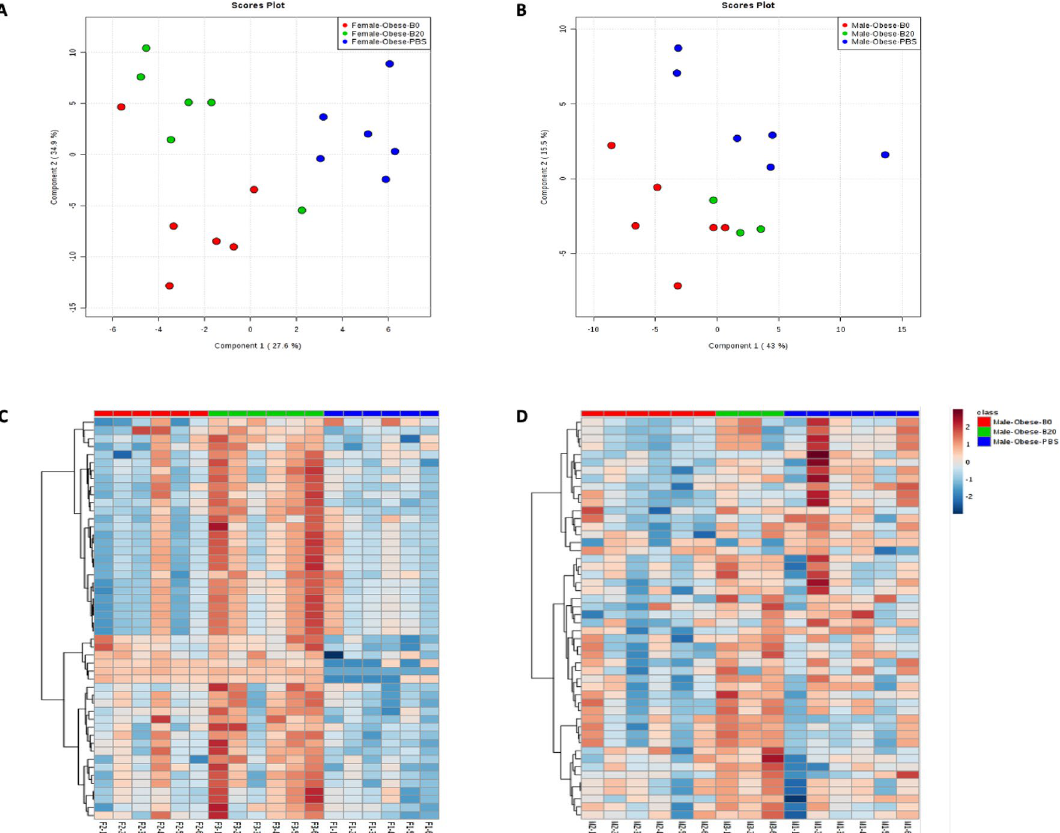
Figure 3. Gut microbial metabolic profiling of female and male mice based on the metabolomic analysis of cecum samples. Within each sex, the B0, B20, and PBS treatments were illustrated in blue, orange, and green. ( A , C ) showed females PLS-DA plots and heatmap while ( B , D ) showed the results from the male groups. The color within each heatmap indicates the expression level of each metabolite, dark red indicates the highest abundance and dark blue indicates the lowest abundance of the metabolite in the